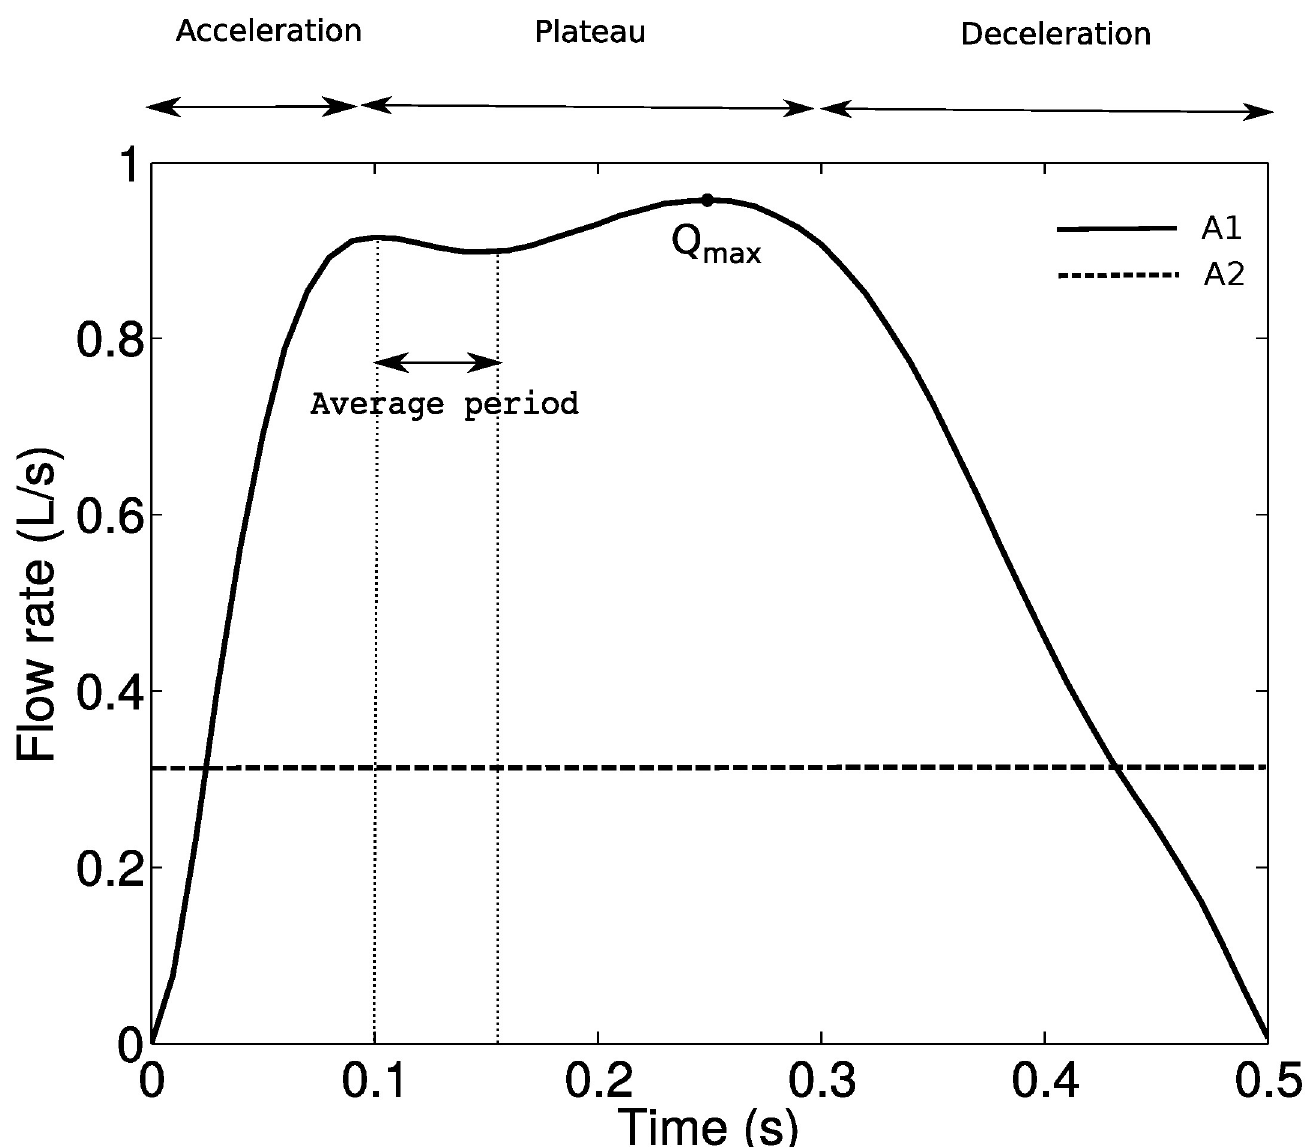
Fig 3. Flow rate profiles of different inhalation conditions, A1 and